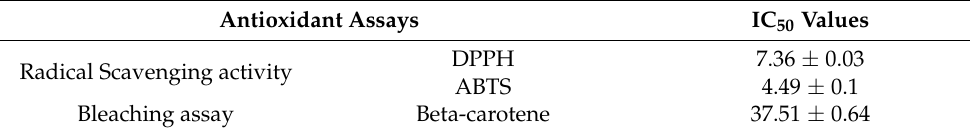
Table 2. Antioxidant activity of tested manuka